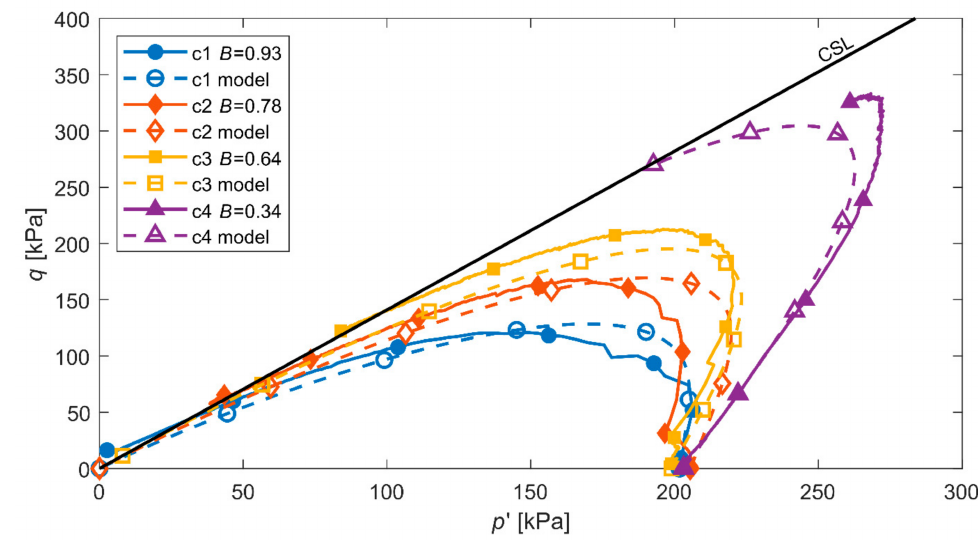
Figure 23. Theoretical predictions of triaxial compression tests of partially saturated Skarpa sand vs. experimental results.